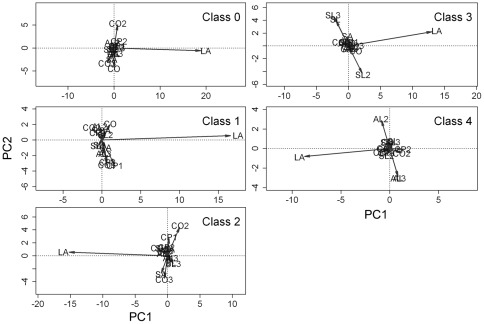
Principal component analysis ordinations (based on matrices of transformed p-values from the SAR models) of the 14 explanatory variables and the spatial autoregressive parameter λ for each of the 5 DBH classes at the 20-m scale of the count data.Classes 0 to 4 are defined as in Figure 1. The abbreviations in the third-degree polynomial equations of altitude, convexity and slope are as follows: altitude (AL), altitude2 (AL2), altitude3 (AL3), convexity (CO), convexity2 (CO2), convexity3 (CO3), slope (SL), slope2 (SL2) and slope3 (SL3). The abbreviations of the sine-cosine function of aspect and the spatial autoregressive parameter λ are as follows: cos(aspect) (CA), sin(aspect) (SA) and λ (LA). The abbreviations of the first three principal components of the soil variables are as follows: the first principal component (CP1), the second principal component (CP2) and the third principal component (CP3).